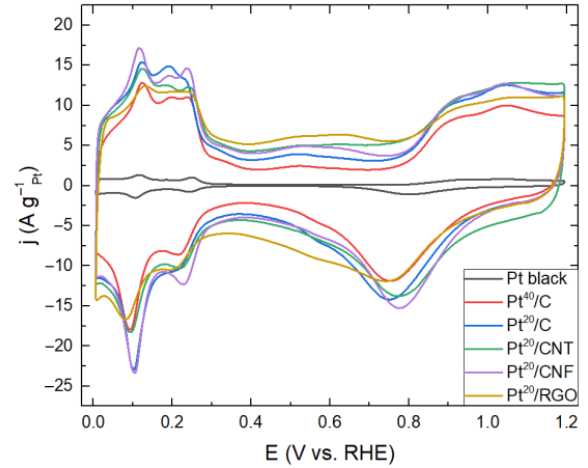
Figure 1. CVs of Pt black, 40 wt.%-Pt/C (Pt 40 /C), 20 wt.%-Pt/C (Pt 20 /C), 20 wt.%-Pt/CNT (Pt 20 /CNT), 20 wt.%-Pt/CNF (Pt 20 /CNF) and 20 wt.%-Pt/RGO (Pt 20 /RGO) recorded in N 2 -saturateted 0.5 M H 2 SO 4 solution at the potential sweep rate of 20 mV/s. The current density of the double-layer region characterizes carbon support. Table 1. ESA and average particle size (d) of the